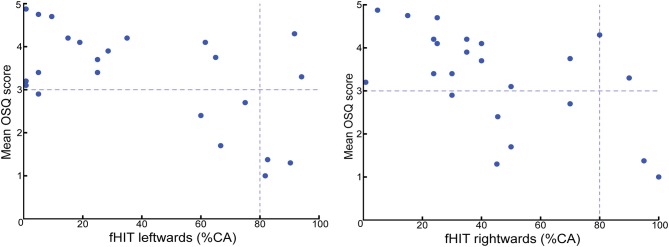
fHIT outcome (percentage of correct answers, %CA) vs. mean OSQ score. The horizontal interceptive line represents the cut-off value of the OSQ; a value of three or more is considered as moderate to extreme oscillopsia severity. The vertical interceptive line represents the cut-off value of the fHIT; a %CA-value of <80 was considered abnormal. This study showed a moderate correlation between the severity of oscillopsia tested by the OSQ, and percentage of correct answers on the fHIT for both rightwards (rs = −0.559; p = 0.006) and leftwards (rs = −0.396; p = 0.061) head impulses.